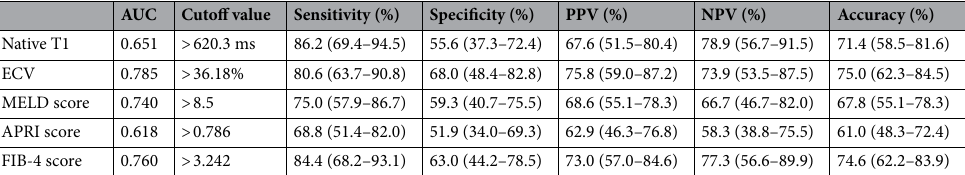
Table 2. Diagnostic performance of hepatic native T1 and MRI-derived extracellular volume fraction as well as clinical scores of liver disease severity for the differentiation between patients with liver cirrhosis of Child– Pugh classes A and B. ECV extracellular volume fraction, MELD model of end-stage liver disease, APRI score aspartate aminotransferase to platelet ratio index, FIB-4 score fibrosis 4 score, AUC area under the curve, PPV positive predictive value, NPV negative predictive value.